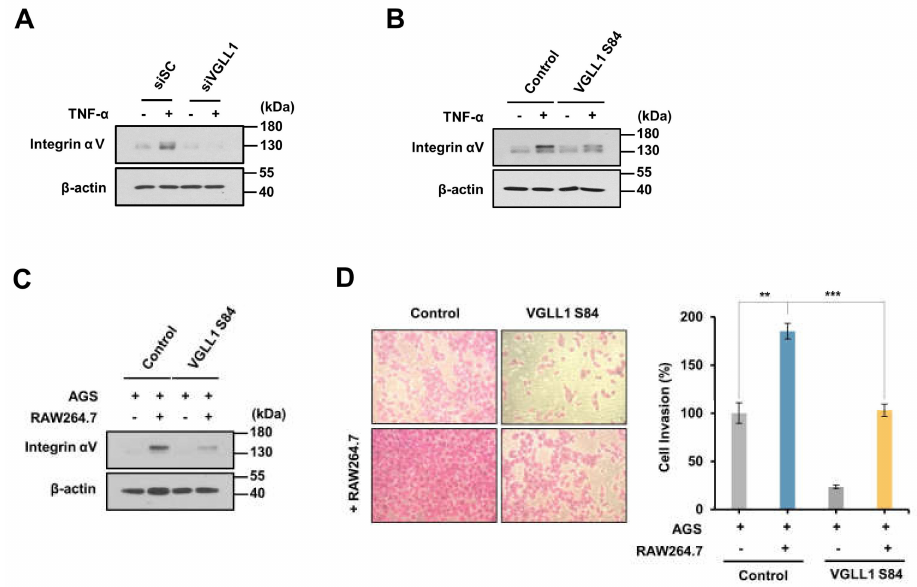
Figure 4. VGLL1 is involved in TNF − α − induced expression of integrin α V. ( A ) The effect of VGLL1 on TNF − α − induced integrin α V expression. AGS cells were transfected with siScramble or siVGLL1 for 24 h and then the cells were treated with TNF − α for 24 h. Integrin α V expression was analyzed by Western blotting (four replicates). ( B ) The effect of VGLL1 S84 peptide on TNF − α − induced expression of integrin α V. After incubation with 20 µ M control peptide or VGLL1 S84 peptide for 1 h, AGS cells were treated with TNF − α for 24 h. Integrin α V expression was analyzed by Western blotting (three replicates). ( C , D ) AGS cells were cocultured with RAW264.7 cells for 24 h in the presence of control or VGLL1 S84 peptide. ( C ) The effect of VGLL1 on integrin α V expression in AGS cells cocultured with RAW264.7 cells. Integrin α V expression was analyzed by Western blotting (three replicates). ( D ) The effect of VGLL1 on the invasion of AGS cells cocultured with RAW264.7 cells. Cell invasion was analyzed using the SRB assay ( n = 3). ** p < 0.01, *** p <